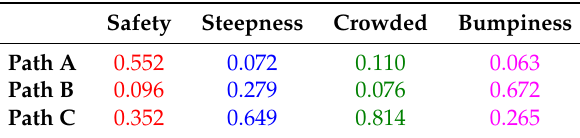
Table 7. Evaluation Score of